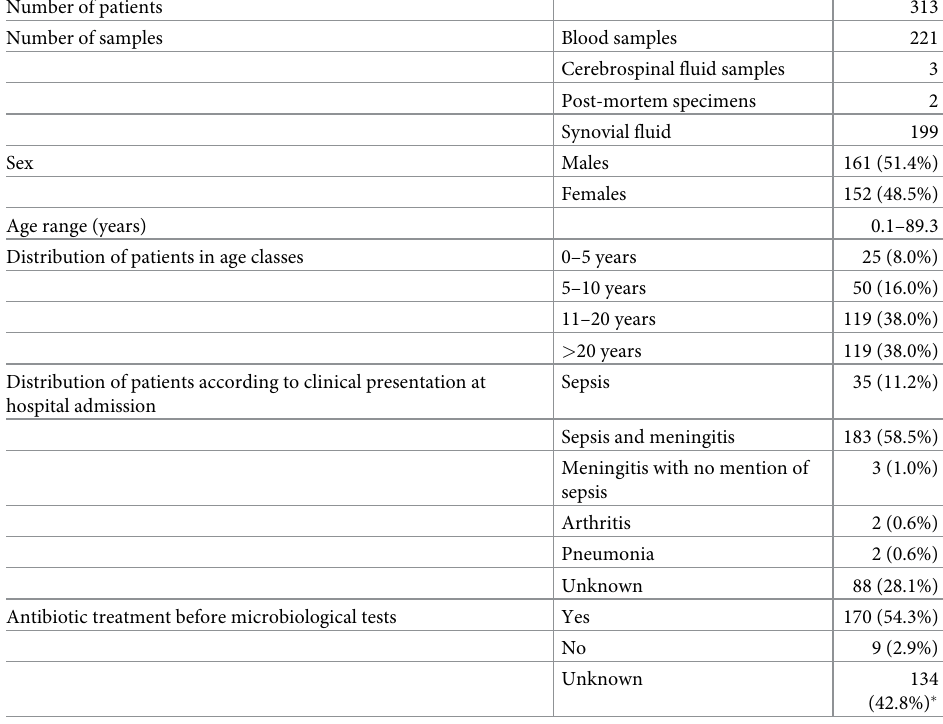
Table 1. Clinical and demographic data of patients included in the study. Number of patients